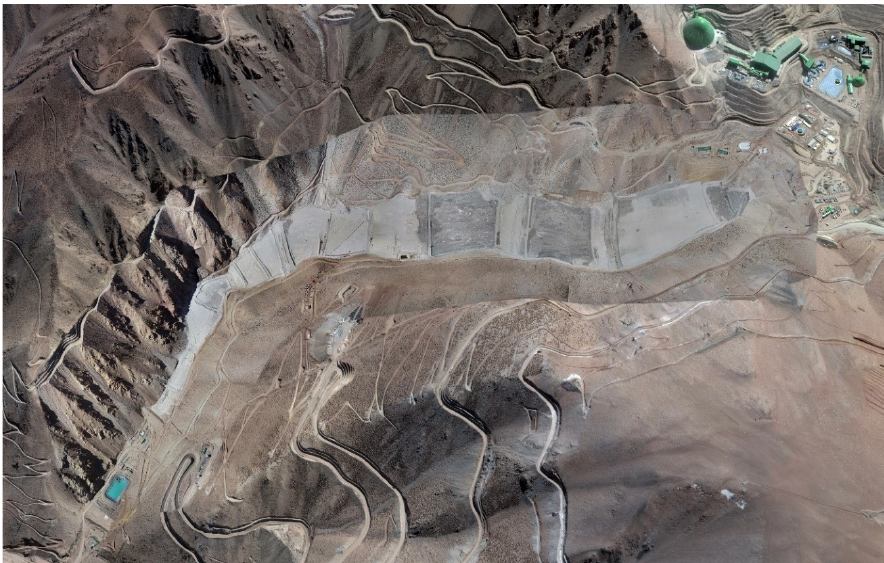
Figure 10. Sand Stack TSF (Cycloned Sand Tailings) SSSTT—Caserones Mine, Chile [18]. Water 2022 , 14 , x FOR PEER REVIEW